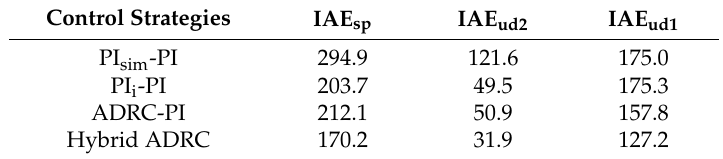
Figure 18. Simulation results of SST system in the simulator with di ff erent control strategies. (Set point: